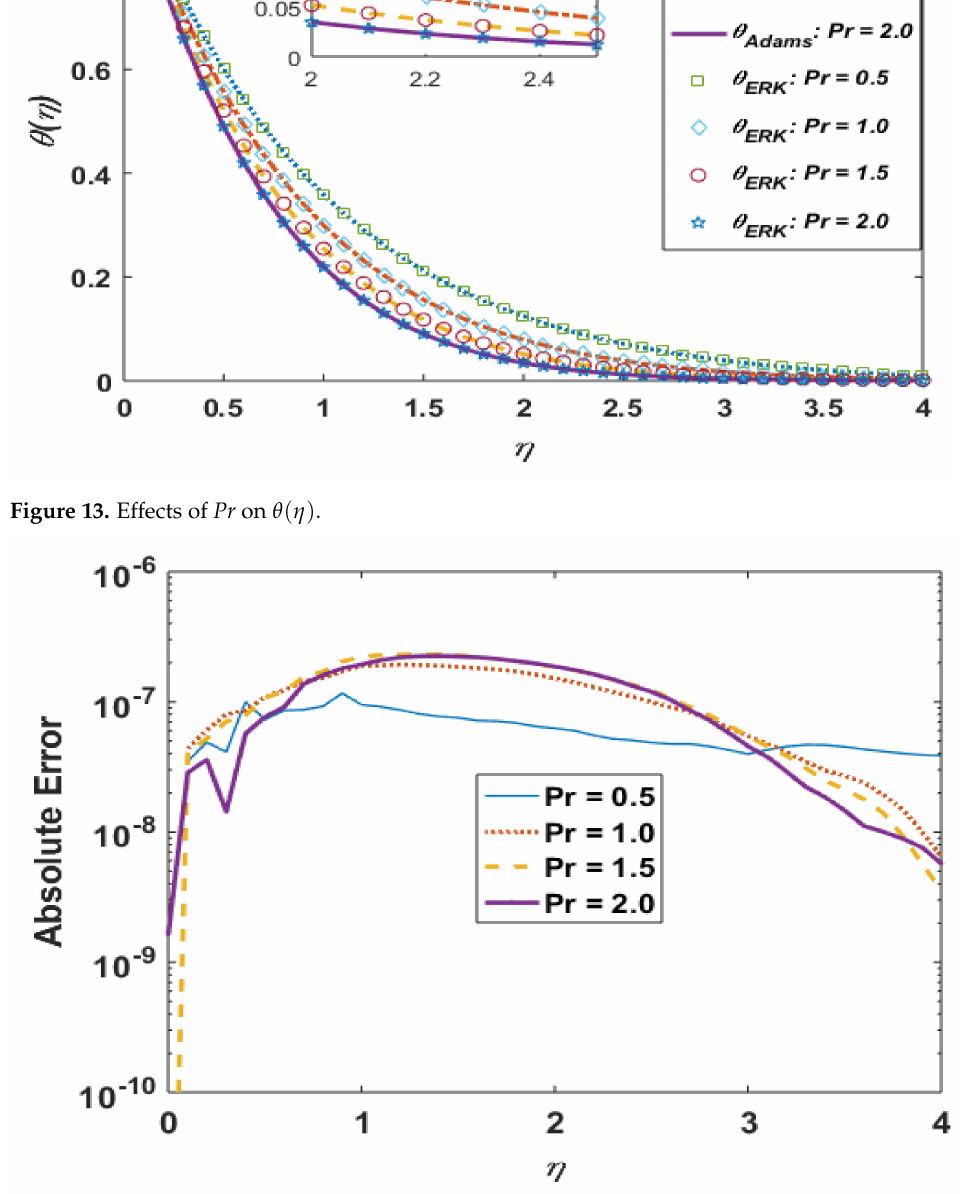
Figure 14. Absolute error in θ ( η ) for different Pr